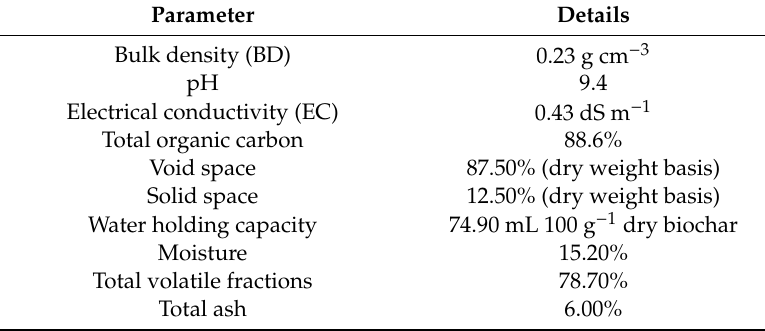
Table 2. Properties of biochar used in current study obtained from AirTerra Inc. (Alberta,